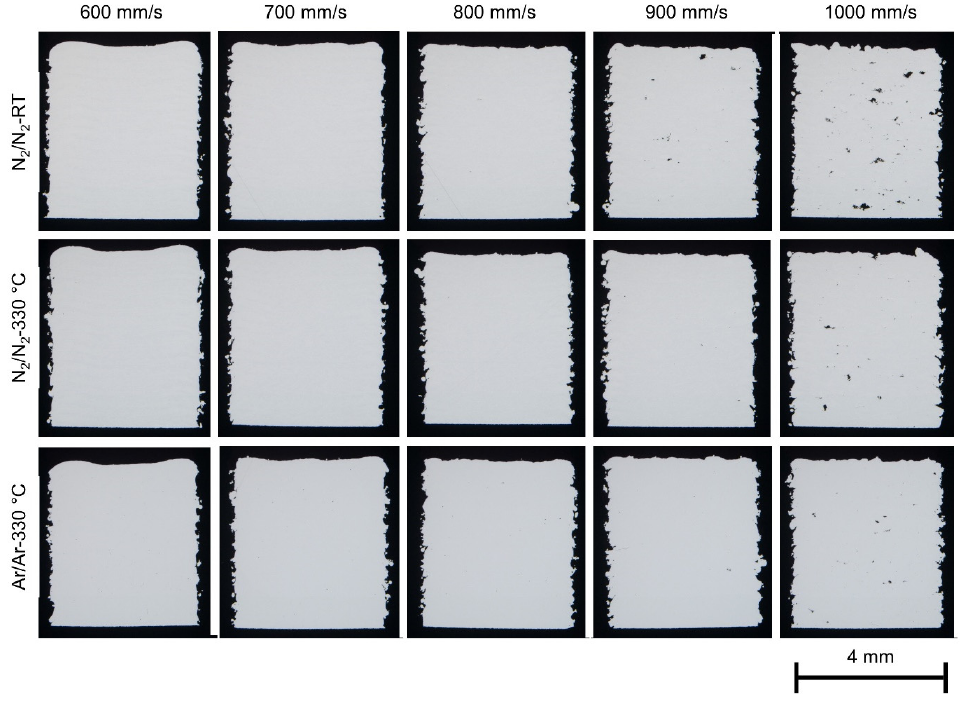
Figure 12. Stereo microscopy of the cubic samples (4 × 4 × 5 mm 3 ) built with the various atomized X2CrNiMoCuWN25-7-4 powders (particle size 20–63 µm). The laser power was 250 W for all the samples, and the laser scan speed was varied from 600 mm/s to 1000 mm/s. The building direction is upward. The vertical sections of the samples were ground and polished for optical metallography.